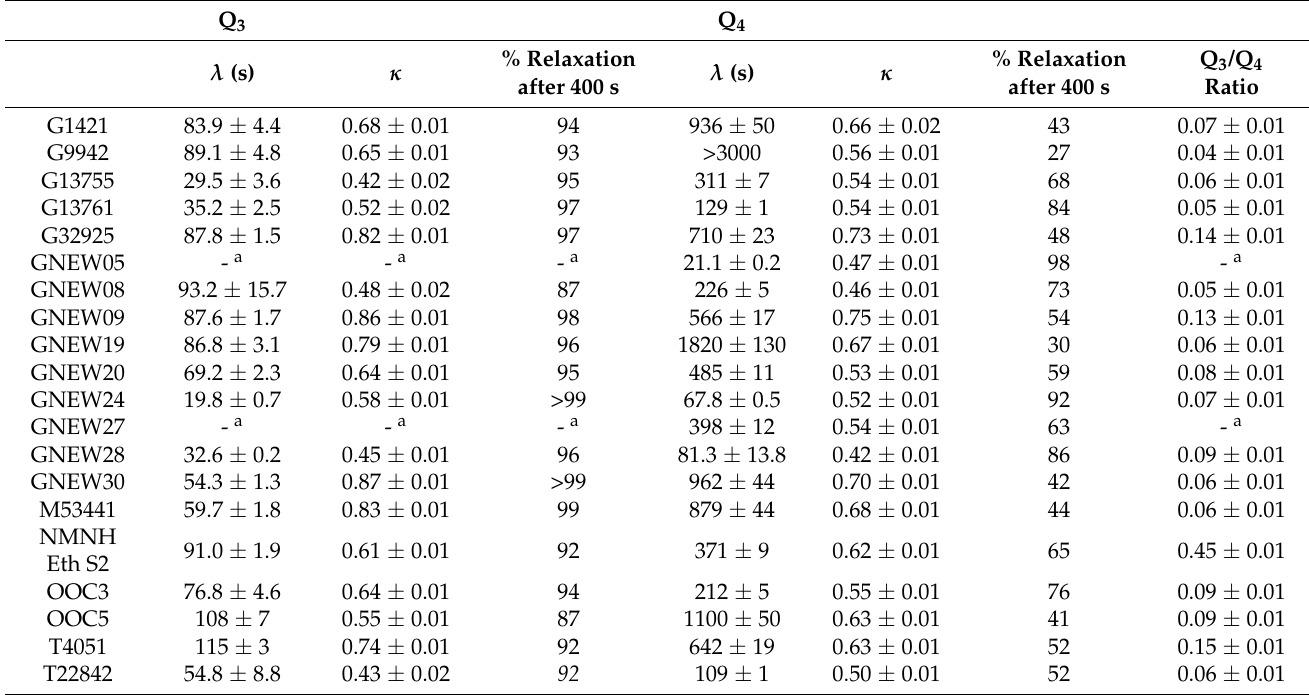
Table 2. Weibull fitting: scale parameter ( λ ) and shape parameter ( κ ) for opal-CT with extrapolated Q 3 to Q 4 ratios. One standard deviation fitting errors are given. Sources given in Appendix